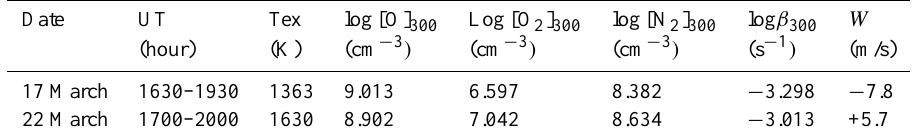
Table 3. Calculated aeronomic parameters at 300km for 17 March and 22 March